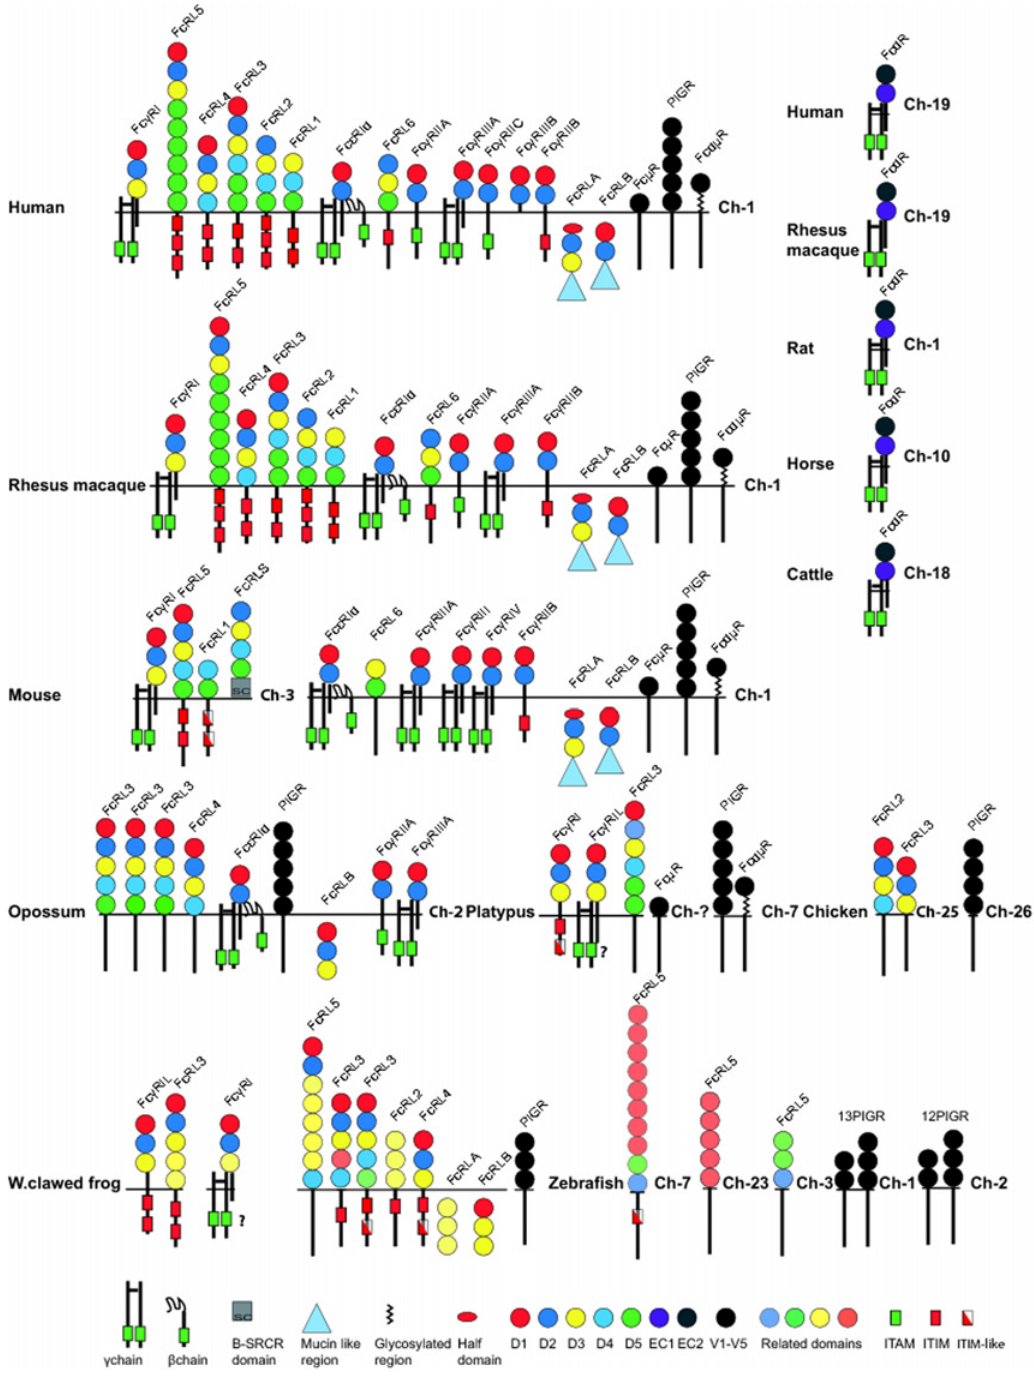
Fig 5. A summary of domain structures and signaling motifs of the various vertebrate Fc receptors. The Ig-like domains are depicted as filled circles with color-coding according to the similarities in sequence based on phylogenetic analyses [24], [58]. The domain type D1, D2, D3, D4 and D5 show a relatively conserved pattern in most tetrapods and have therefore been color-coded in red dark blue, yellow, light blue and green. A phylogenetic analysis of all the individual domains presented in Fig 5 and a few additional receptors are presented in supplementary figure S4. The color-coding in Fig 5 is based on this supplementary figure. The extracellular regions, the transmembrane regions and cytoplasmic tails are not to scale in order to show the positions of potential signaling motifs like ITAMs (green boxes) and ITIMs (red boxes), which regulate the biological function the Fc receptors. Non-consensus ITIMs are also indicated as boxes with half red half white. Some of the intracellular proteins contain C-terminal mucin-like regions that are depicted as blue